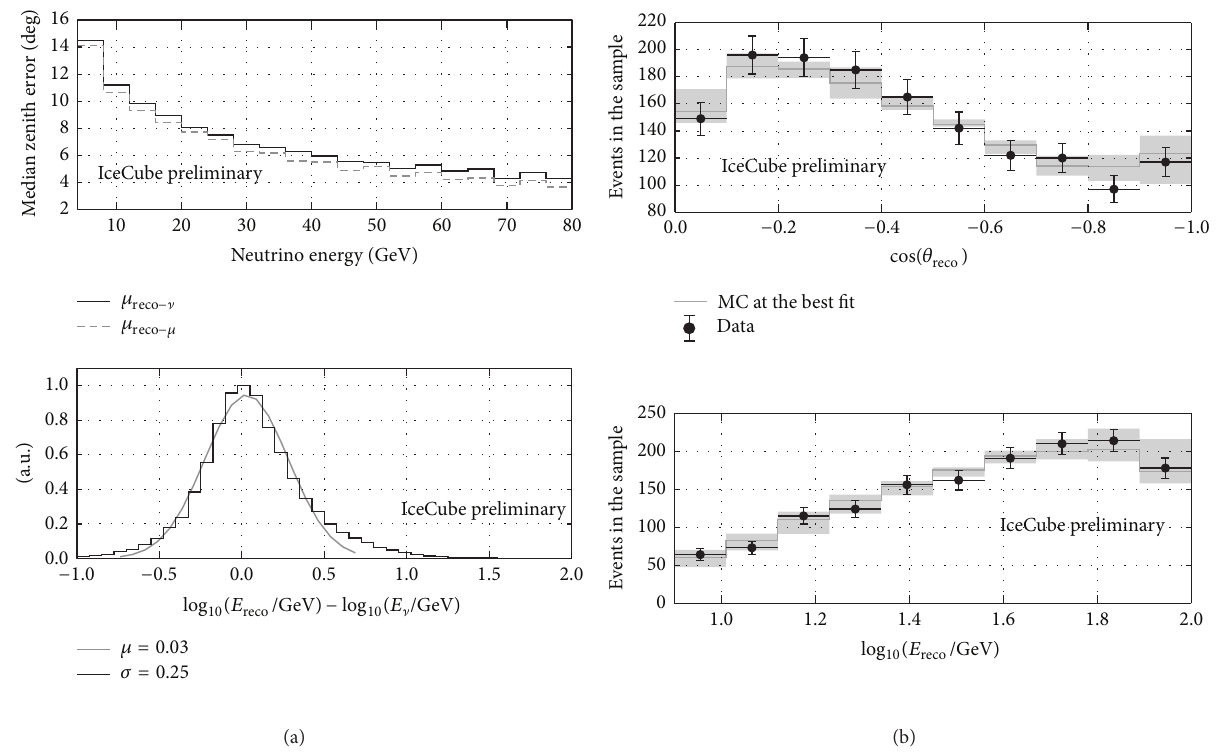
Figure 4: (a) Performance of reconstructions for the ] 𝜇 CC component of the IC86 analysis in zenith angle (top) and energy (bottom). (b) Zenith angle and energy distributions of data and best fit simulation. Statistical errors are added to the data; systematic errors are attributed to the simulation (figure from